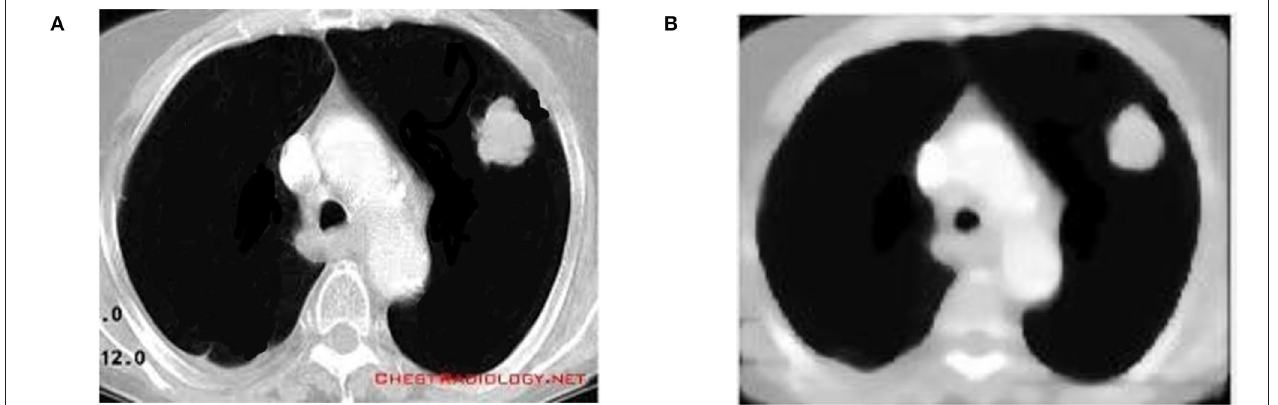
FIGURE 3 | (A) Input CT image. (B) Filtered output.